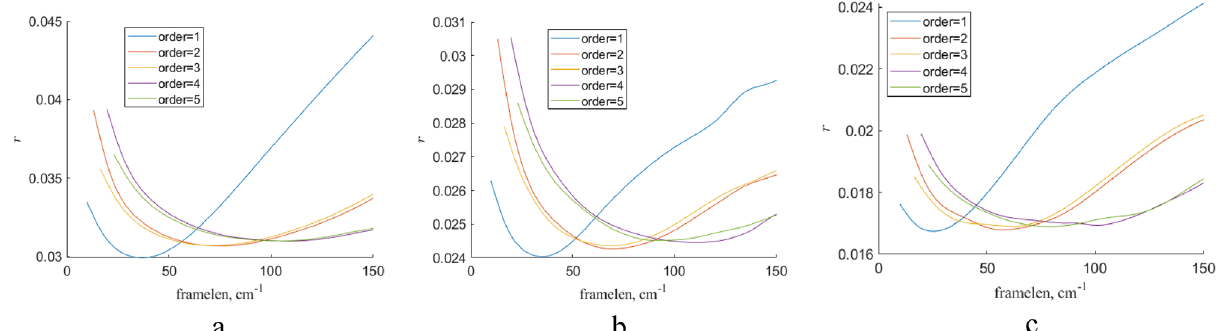
Figure 13. The dependence of r on the polynomial order for Raman spectra of blood on Al substrate ( a ), blue polyester substrate ( b ), and pure blue polyester substrate ( c ) processing by Savitsky-Goley filter. Here, “framelen” parameter means the gliding spectral window, “order” is the order of polynomial used in Savitsky-Goley